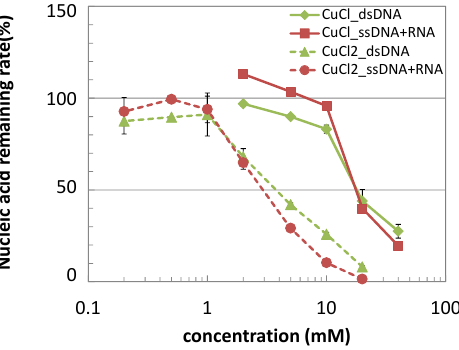
Figure 4. Nucleic acid remaining rates measured at 5 min after adding a certain concentration of CuCl or CuCl 2 (mean ± standard deviation).